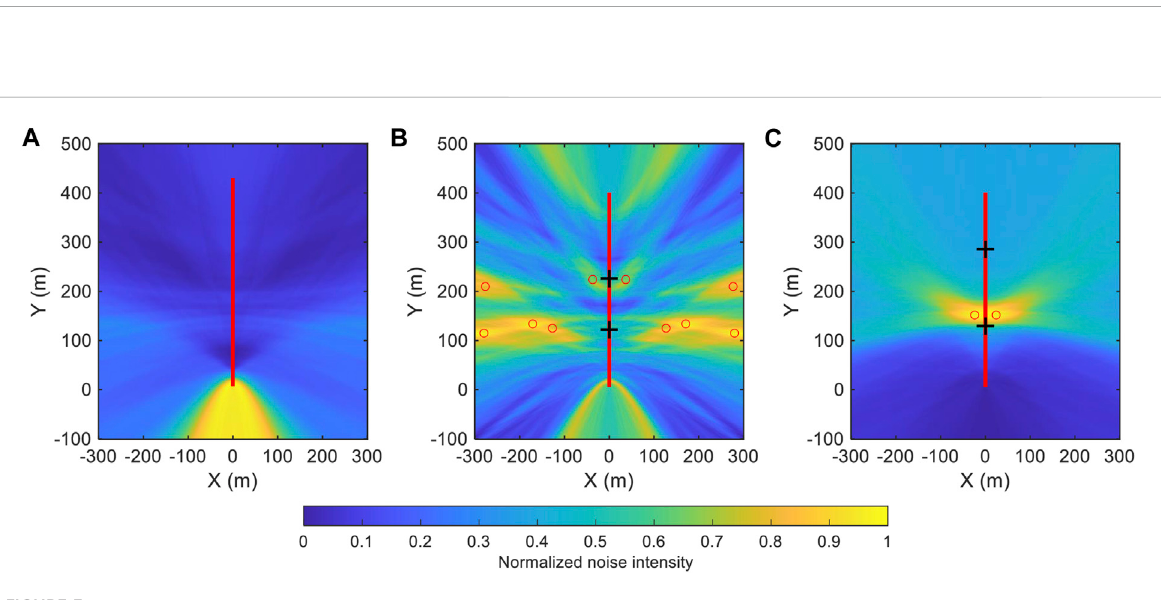
Frontiers in Earth